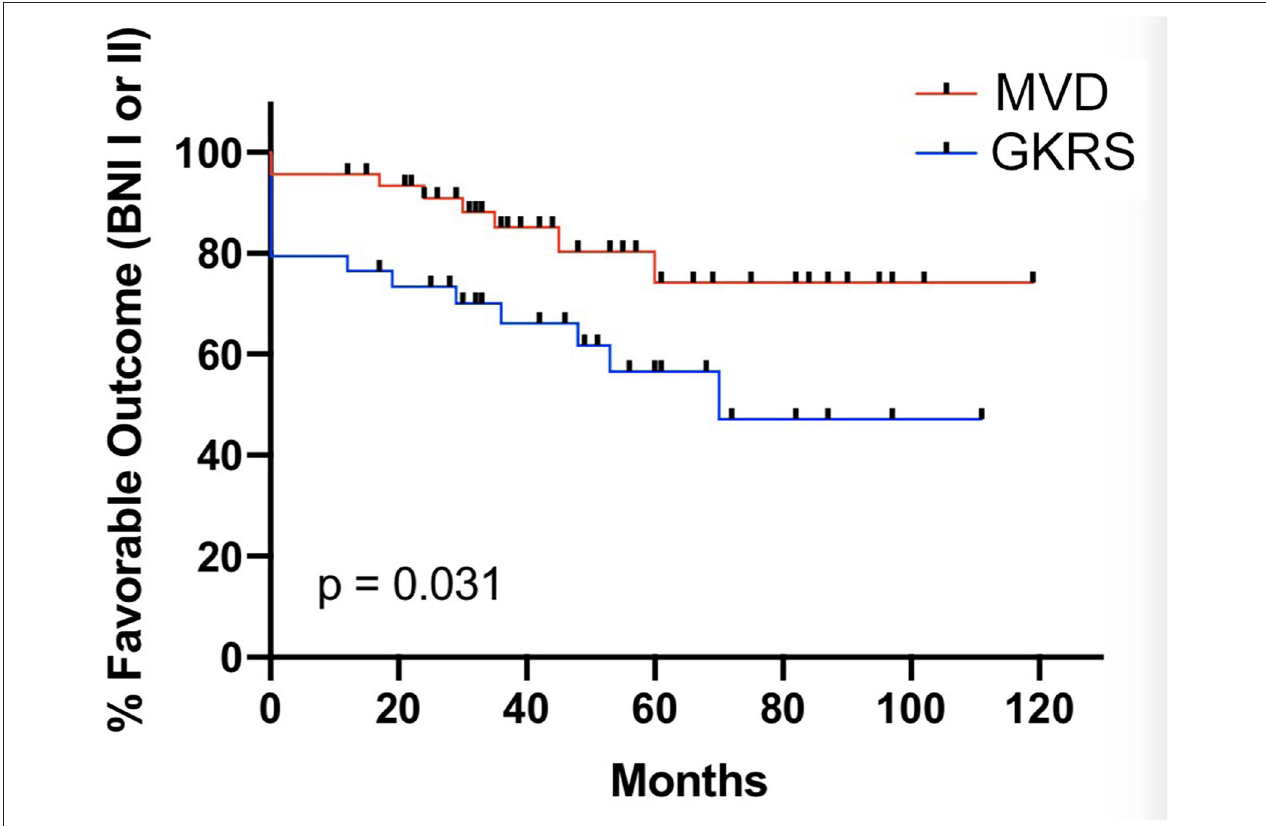
FIGURE 3 | The Kaplan–Meier method was calculated the ability of maintaining the postoperative favorable outcome (BNI I–II) in the MVD group (red line) and GKRS (blue line) group ( p =